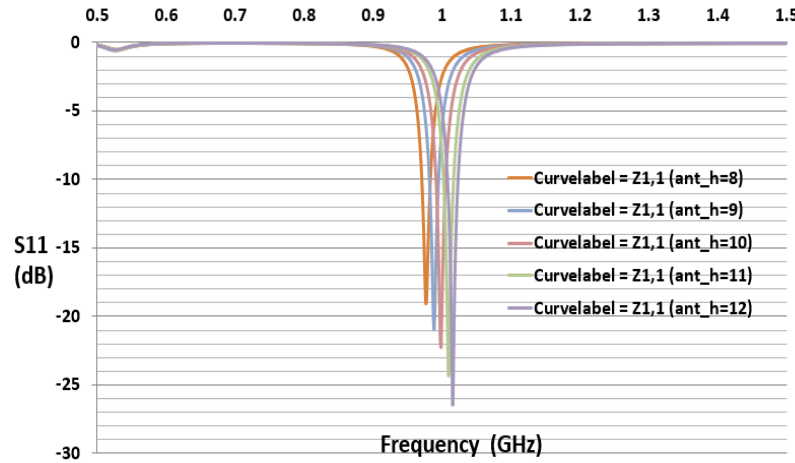
Sensors 2021 , 21 , x FOR PEER REVIEW Figure 7. Simulated S11 results with the variation of parameter ant_h (mm). Figure 7. Simulated S11 results with the variation of parameter ant_h (mm).